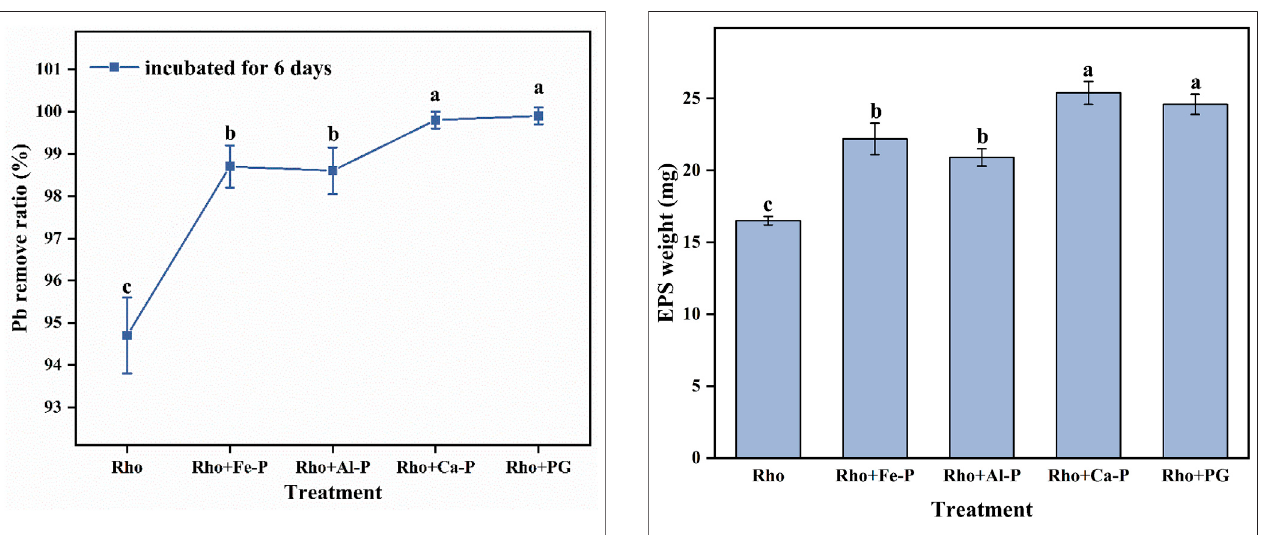
FIGURE4| EPSweightineachtreatmentafter6 daysofincubation.The errorbarsrepresentthestandarddeviationsofthreereplicates.Thesigni fi cant